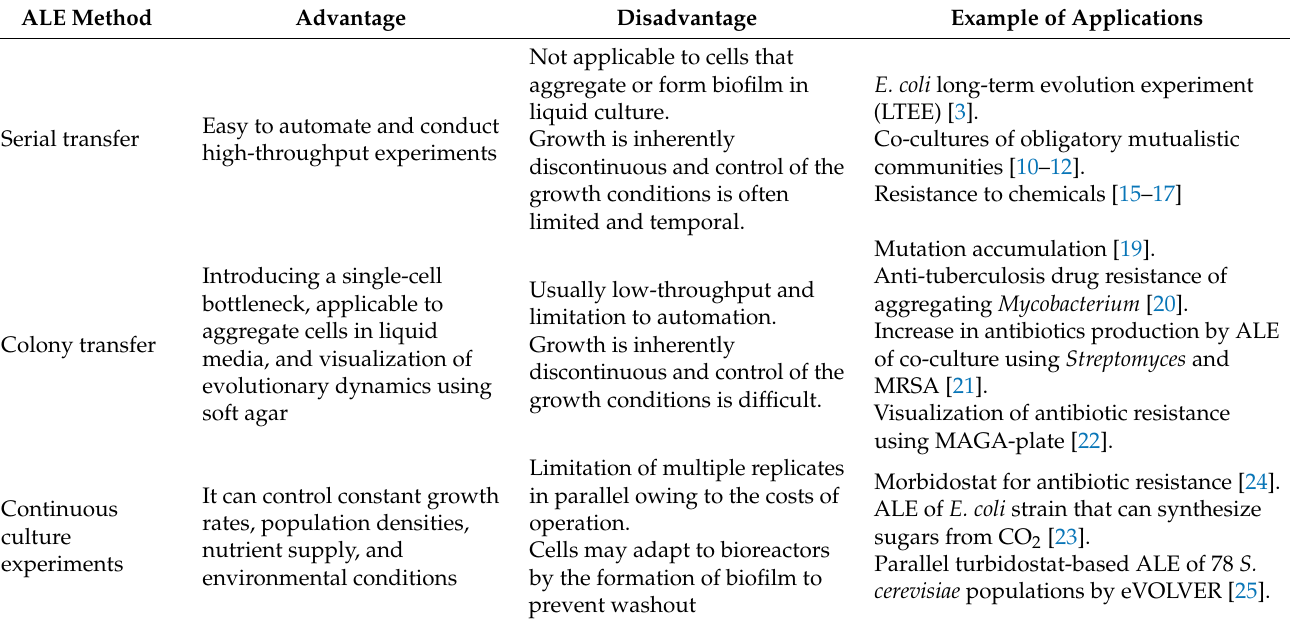
Table 1. Three types of ALE